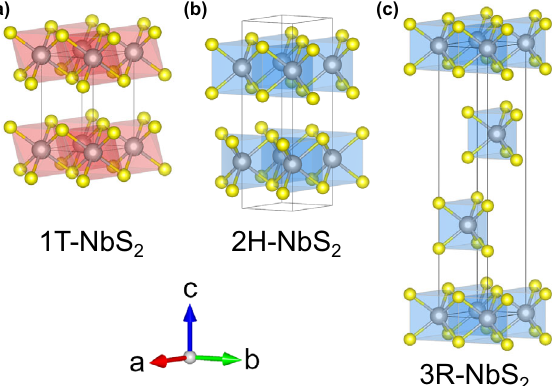
Fig. 1 Polytypes of NbS 2 . Crystalline lattices of 1T-NbS 2 ( a ), 2H- NbS 2 ( b ) and 3R-NbS 2 ( c ). The corresponding 1-, 2- and 3-layer unit cells are marked with black wireframes. The compass shows the directions of the principal axes for all three structures. 2H-NbS 2 and 3R-NbS 2 share the same structure in the a – b plane, but have different stacking of layers along the c axis. For 3R-NbS 2 , only one Nb atom with 6 nearest S atoms are shown for the middle two layers, for a clearer illustration of the stacking. Images produced with VESTA 57 .